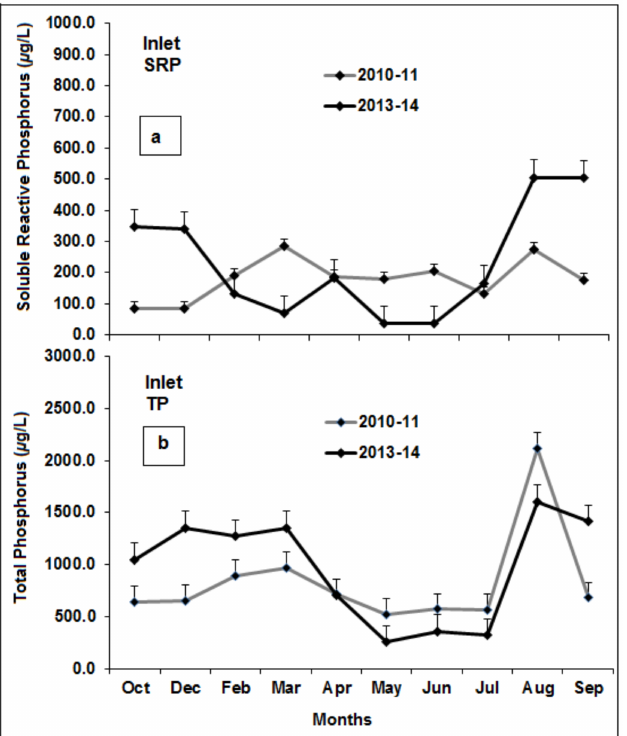
Figure 10. Soluble reactive phosphorus (SRP) and total phosphorus (TP) concentrations ( µ g/L) measured at combined inlet near Magüayo for common sampling dates during ( a ) 2010–2011 and ( b )